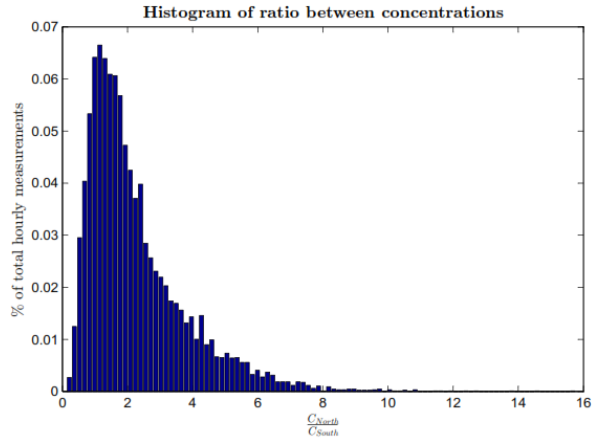
Figure 1. Histogram of ratio between the north side and south side receptors for near-parallel wind directions for Hornsgatan, Stock-